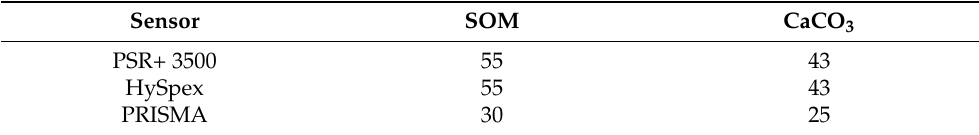
Table 3. Number of samples used for model